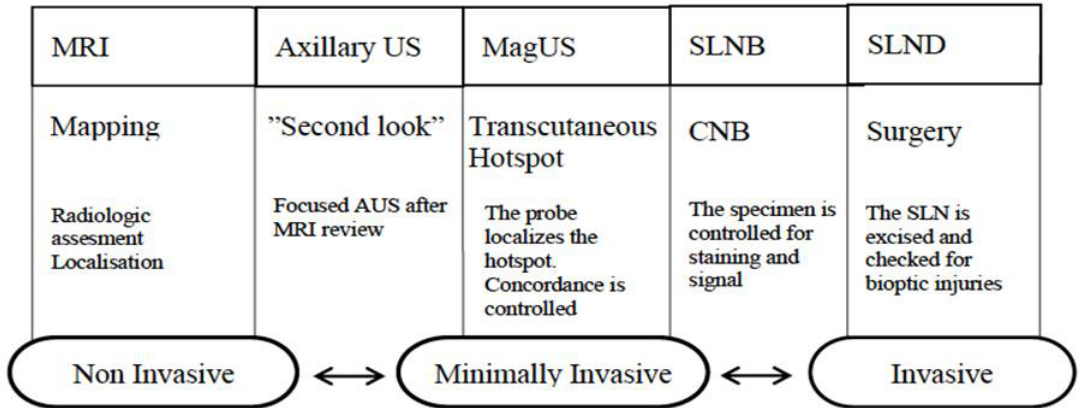
Figure 4. Flowchart showing the MagUS process.